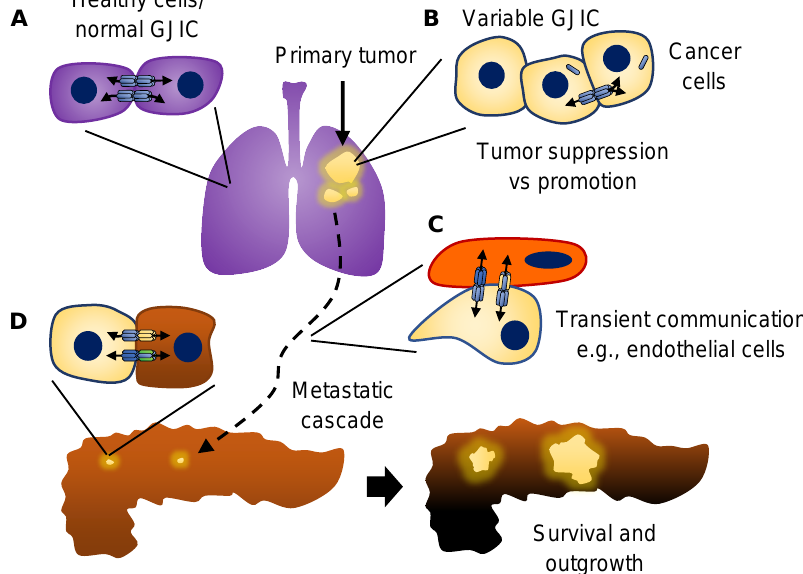
Figure 2. Role of gap junctions during cancer progression. ( A ) GJIC is an essential part of cellular and tissue homeostasis in healthy cells. ( B ) During tumor initiation, loss of GJIC in cancer cells and downregulation of connexin expression is commonly observed. However, the functions of connexins and gap junctions can suppress or facilitate tumor growth. ( C ) During the multi-step process of metastasis, GJIC has been shown to facilitate interactions with other cells (e.g., endothelial cells) to promote the steps of the metastatic cascade. ( D ) Upon reaching a secondary site, adaptation to a new microenvironment must occur and evidence has shown that GJIC between metastatic cells and stromal cells of these sites can promote survival and outgrowth, completing the process of metastasis.